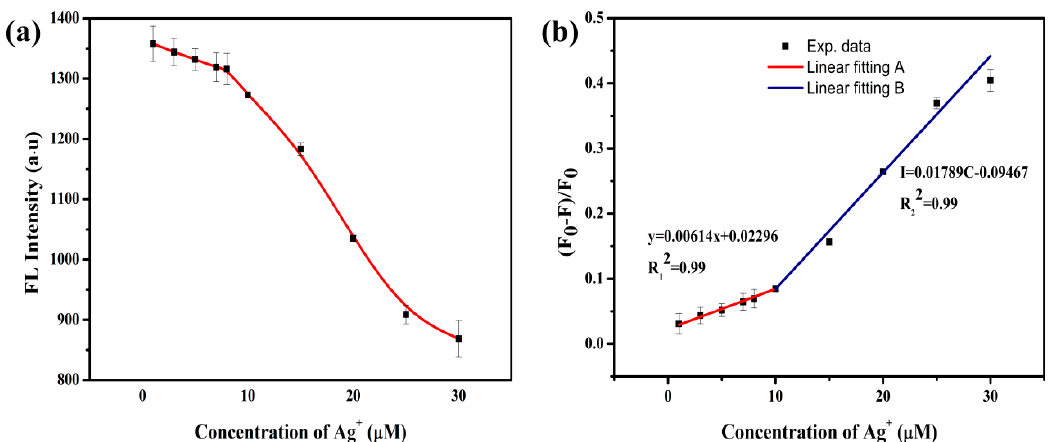
Figure 5 . N-CQDs were used for the detection of Ag + in aqueous solution. ( a ) Fluorescence intensity of N-CQDs at different concentrations of Ag + ; ( b ) fluorescence quenching efficiency of N-CQDs at different concentrations of Ag + . In the figure, F 0 is the fluorescence intensity of N-CQDs; F is the fluorescence intensity of N-CQDs when different concentrations of Ag + are added; (F 0 − F)/F 0 is the fluorescence quenching efficiency of N-CQDs.